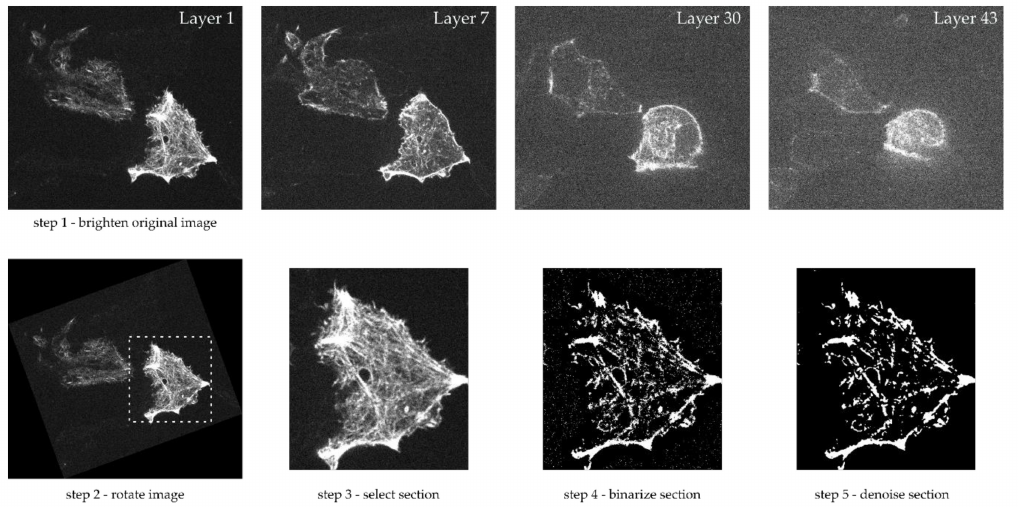
Figure 1. Top: Image sequence over several layers of an insulin-secreting MIN6 cell transfected with mTagRFP-T-Lifeact-7, taken with a Spinning Disk Confocal Microscope, white = actin; bottom: pretreatment image processing